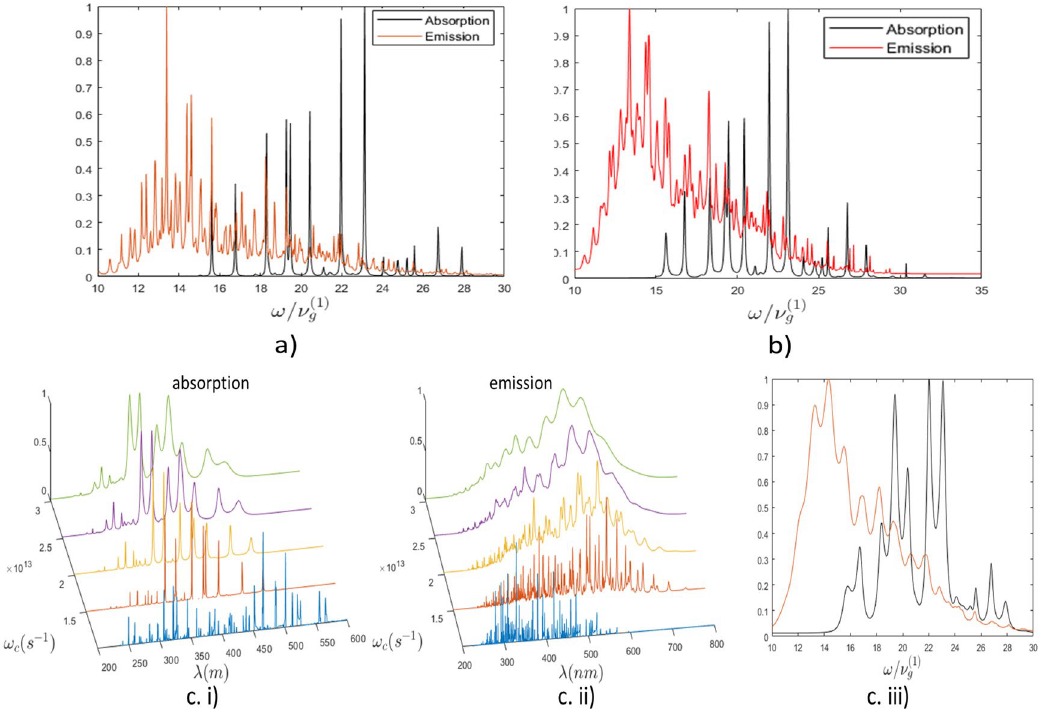
Figure 5. Emission lineshape (solid blue line) versus absorption lineshape (orange dotted line) of nitrogen dioxide. Liouvillean includes: ( a ) electronic-radiation and vibrational dampings, ( b ) electronic- radiation, electronic-phonon and vibrational dampings, with cutoff frequency ω c = 2 π 3.2 × 10 12 s − 1 , ( c ) electronic-radiation, electronic-vibrational-radiation, cross-term, electronic-phonon and vibrational dampings for (i) absorption, (ii) emission spectra versus wavelengths for several cutoff frequencies ω c = 2 π [ 1.6, 2.4, 3.2, 4.0, 4.8 ] × 10 12 s − 1 , (iii) spectra for the largest ω c . We use 3 vibrational levels and 3 modes. ( g ) 2 π [ 1322.5, 750.9, 1616.0 ] cm − 1 , ω ( e ) = 2 π 28000 cm − 1 with displacements s i = 10 − 11 m, ν i =